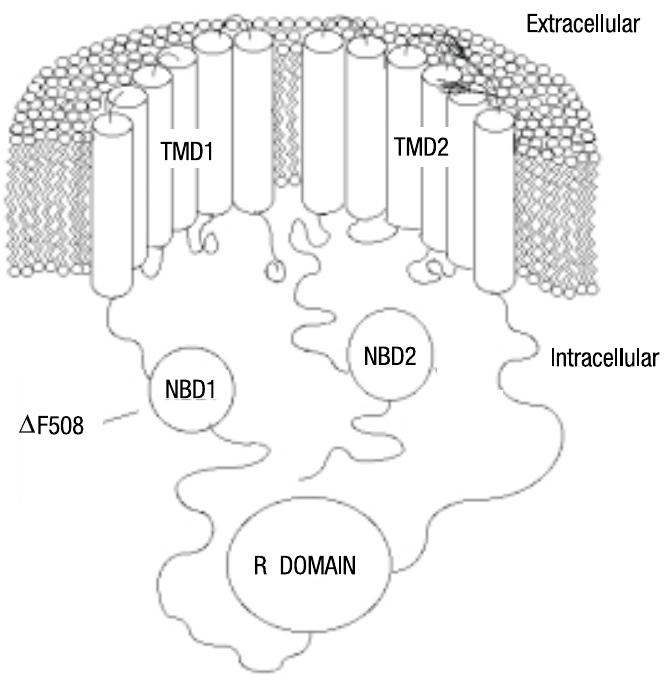
Fig. 1 – Predicted two-dimensional structure of the CFTR protein. The CFTR domains shown are: TMD1 and TMD2-transmembrane-spanning do- mains 1 and 2, respectively; R domain-regulatory domain; NBD1 and NBD2- nucleotide-binding domains 1 and 2, respectively. The most common muta- tion, (cid:6) F508, is found in NBD1. Figure modified from Ref. Collins et al.